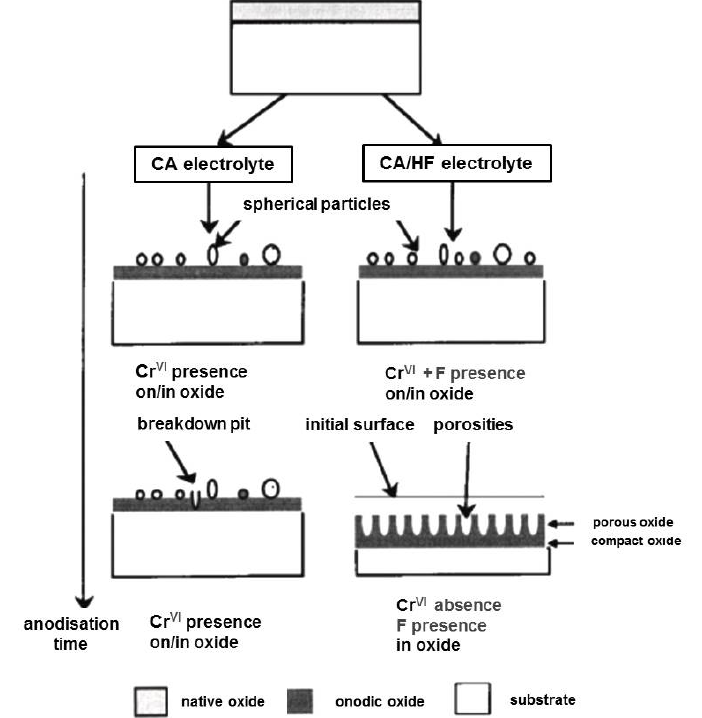
Figure 2. Proposition of a growth mechanism. Reprinted from [49] with